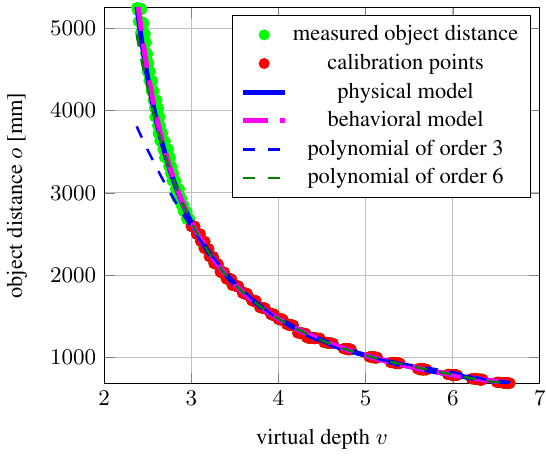
Figure 5: Results of the second experiment for the depth map calibration. Object distances up to approx. 2 . 6 m were used for calibration. The calibration was performed based on the physical model, the behavioral model and the curve fitting approach.